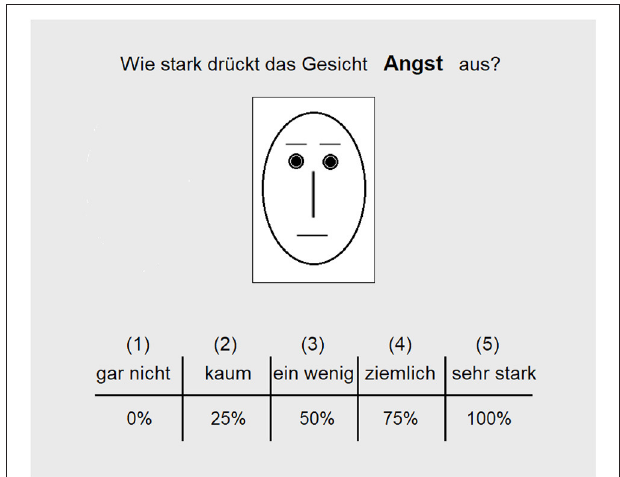
FIGURE 1 | In the perception of facial expressions (PFE) task, schematic faces were displayed. In the present example, a face with a neutral expression is shown. Images of faces remained on the screen until response. Participants had to evaluate the face with respect to the degree to which it expresses a certain affect (in the example the question is “How strongly does the face express fear?”). At the bottom of the screen, the response format was shown. Participants evaluated the expression of seven affects (positive: happiness, attraction; negative: fear, anger, sadness, disgust, and rejection). Answers were given on a keyboard by pressing the “1”, “2”, “3”, “4”, or “5”